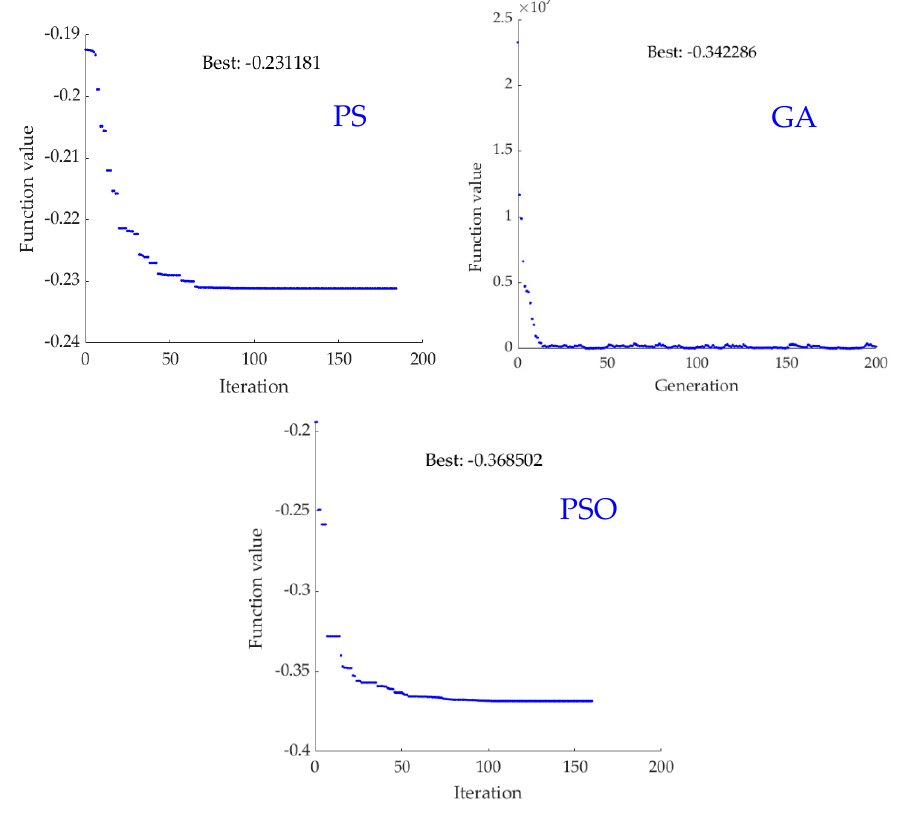
Figure 6. Performance comparison results of optimization algorithms for the base case.